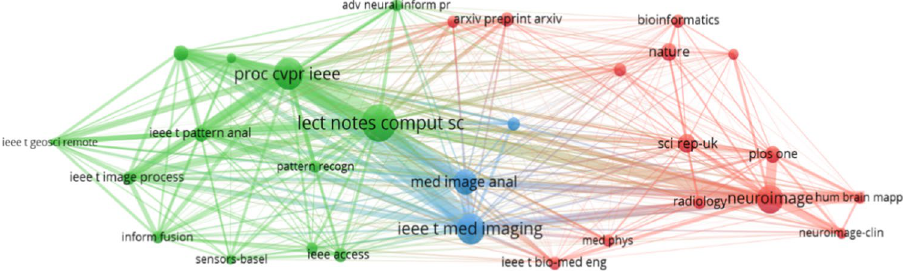
Fig. 9 Co-authorship network of MMDLM-related publica-